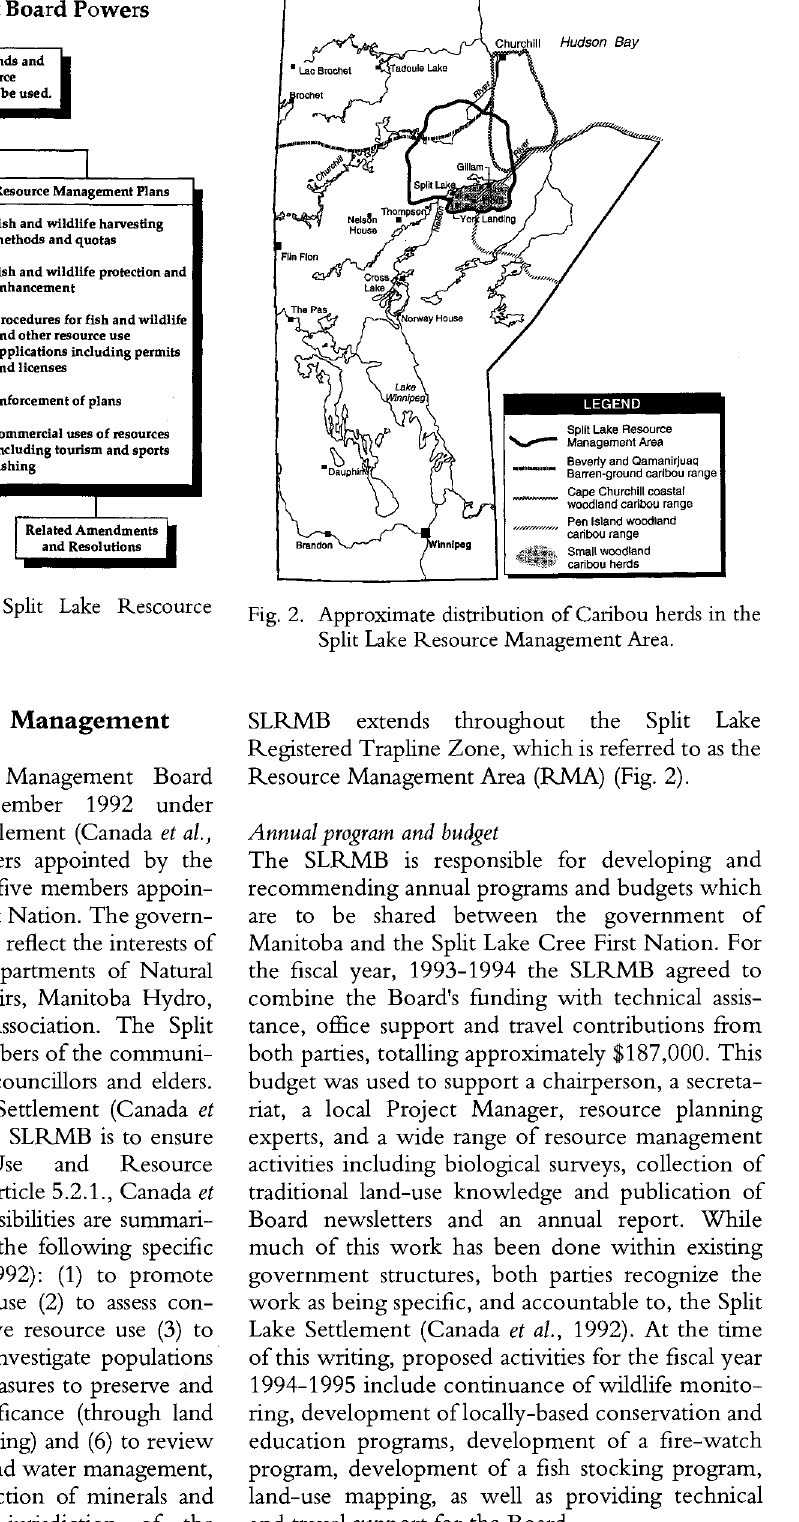
Fig. 1. Responsibilities of the Split Lake Rescource Management Board.